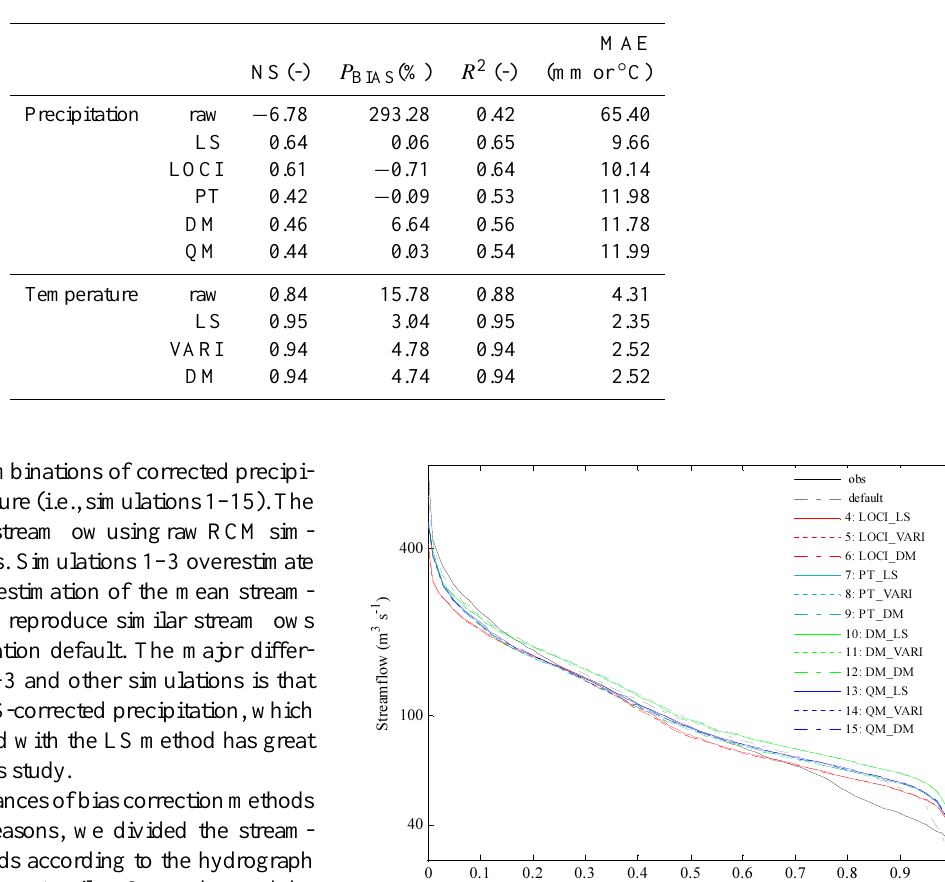
Table 6. Time-series-based metrics of bias-corrected precipitation and temperature calculated on a monthly scale at the Bayanbulak Station.